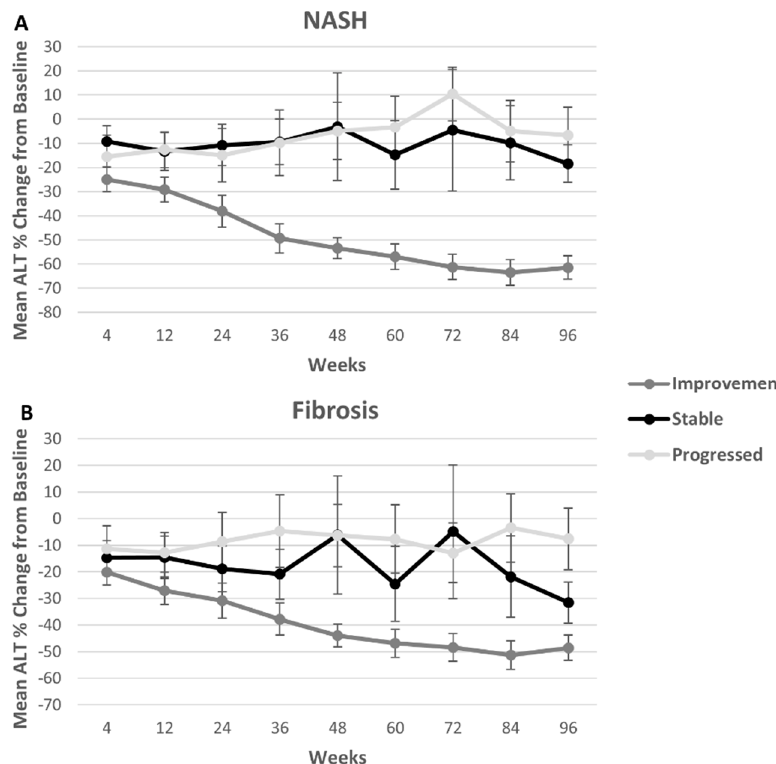
Figure 2. Changes in ALT concentrations from baseline were similar in stable patients compared to those with progressed disease when measured by the fibrosis and NASH assessment, though with the fibrosis score participants were more variable. The percent change in ALT from baseline is shown at each time point for participants that showed progression (lightest gray), improvement (dark gray) and that stayed stable from baseline to 96 weeks (black) was added for NASH assessments ( A ) and fibrosis ( B ). ALT (alanine aminotransferase); NASH (nonalcoholic steatohepatitis).